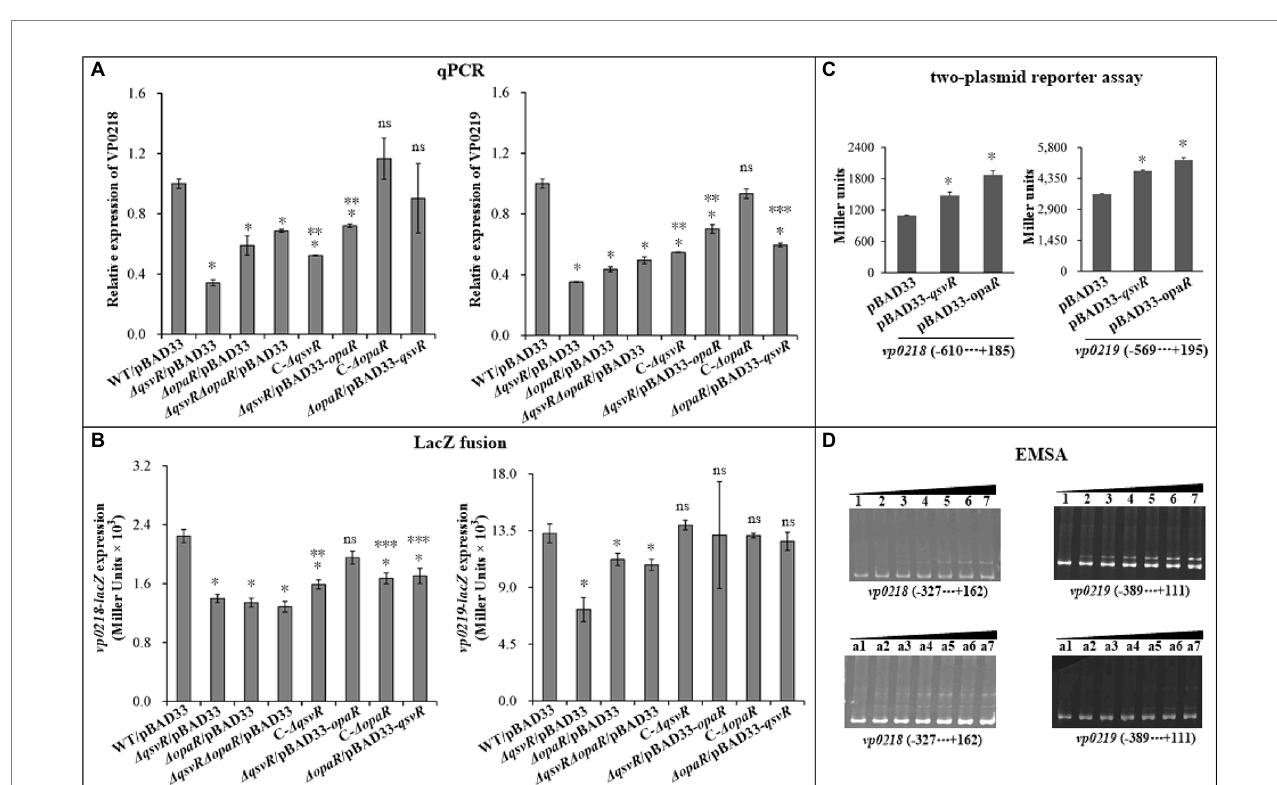
FIGURE 7 Regulation of vp0218 and vp0218 by QsvR and OpaR. qPCR (A) , LacZ fusion (B) , Two-plasmid reporter assay (C) , and EMSA (D) were carried out as described in Figure 2. Lanes 1, 2, 3, 4, 5, 6, and 7 in the EMSA (D) data contain 0, 0.4, 0.8, 1.2, 1.4, 2.0, and 2.4 pmol of His-OpaR, respectively. Lanes a1, a2, a3, a4, a5, a6, and a7 contain 0, 0.021, 0.042, 0.063, 0.083, 0.11, and 0.13 pmol of His-QsvR, respectively. Negative and positive numbers indicate the nucleotide positions upstream and downstream of each target gene, respectively. The single asterisk symbol (*) indicates statistical significances relative to WT/pBAD33 or E. coli 100 λ pir/pBAD33 ( p < 0.01). The double asterisk symbol (**) indicates statistical significances relative to Δ qsvR /pBAD33 ( p < 0.01). The three asterisk symbol (***) indicates statistical significances relative to Δ opaR /pBAD33 ( p < 0.01). The ‘ns’ means no significant differences relative to WT/ pBAD33 ( p >